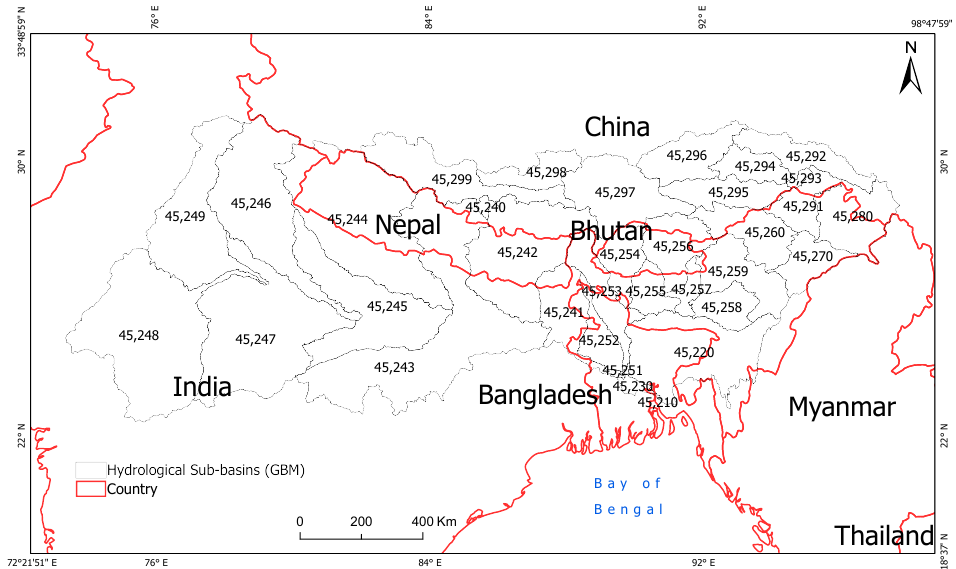
Figure 2. Hydrological sub-basins’ boundaries of the Pfafstetter level-05 of GBM. Numbers are the Pfafstetter identification codes. Country boundaries are the red